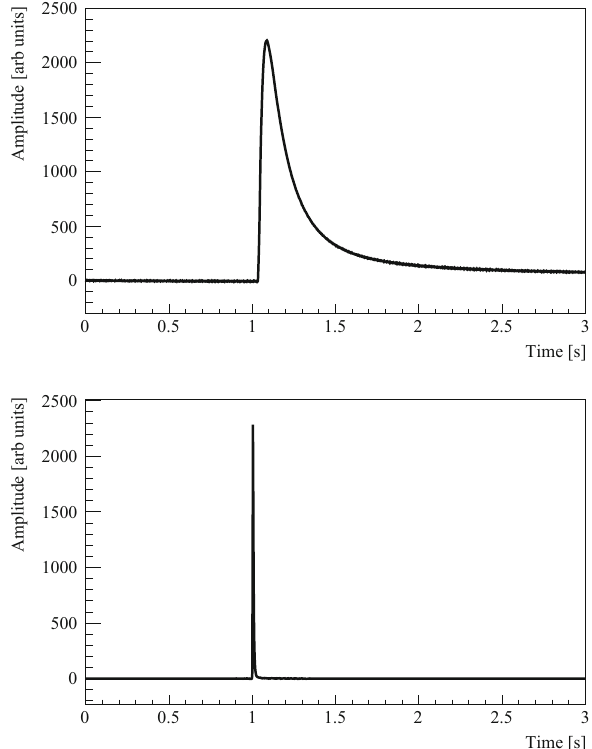
Fig. 2 TypicalaveragepulsesforLMOdetector(top)andLD(bottom) readout. Note that the LMO pulses are significantly longer in duration owing to the larger heat capacity of the LMO compared to the much smaller Ge